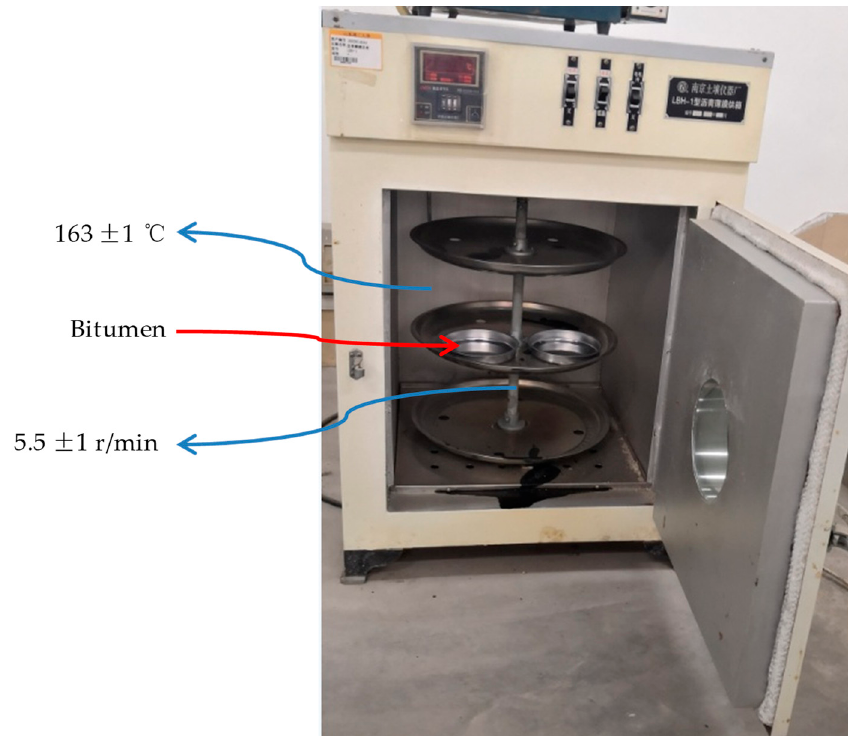
Figure 2. The test equipment and test conditions.